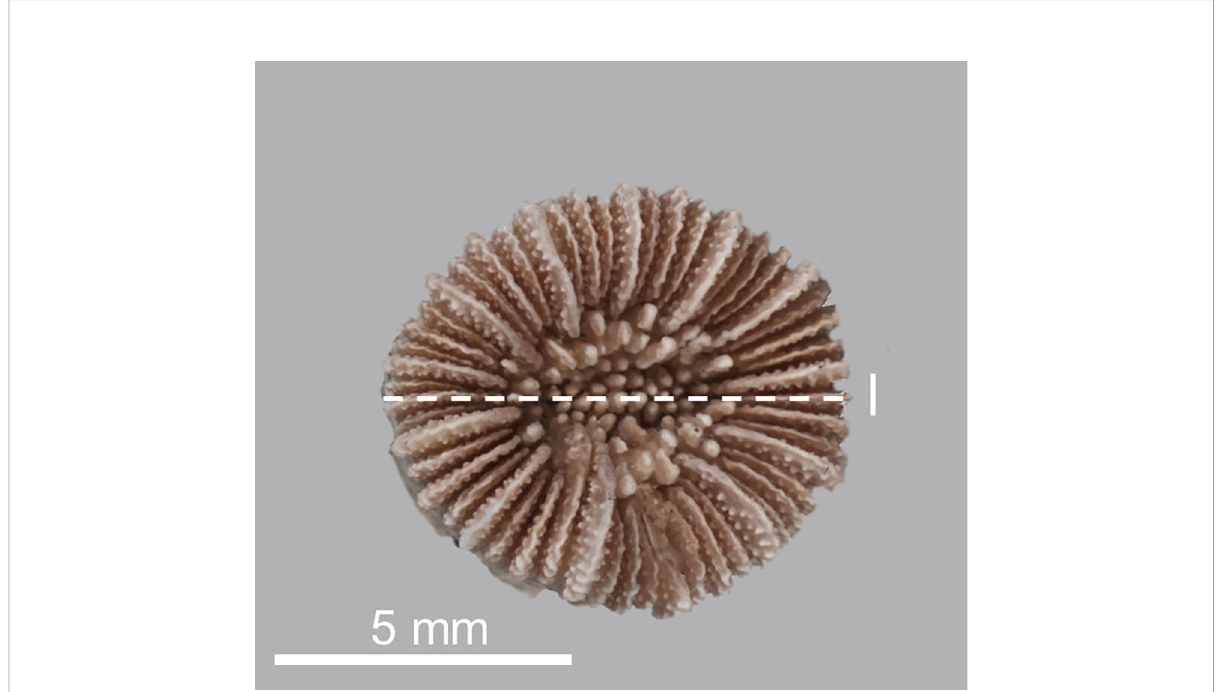
FIGURE 2 Skeleton of Paracyathus pulchellus . Dotted line indicates polyp length (l, maximum axis of the oral